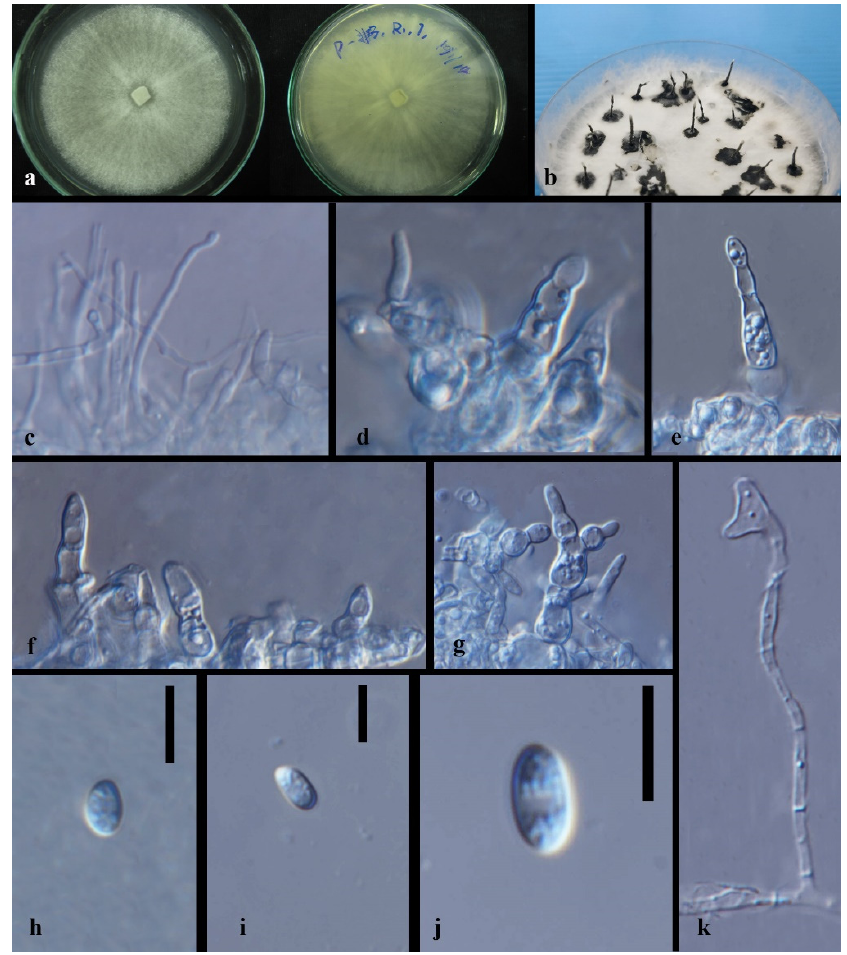
Figure 19. Xylaria venosula . ( a ) Coloy on PDA (MFLUCC 14-0114) (left-front view, right-reverse view). ( b ) Stroma on 2% MEA. ( c – g ) Conidiophores with conidia. ( h – j ) Conidia. ( k ) Appressoria-